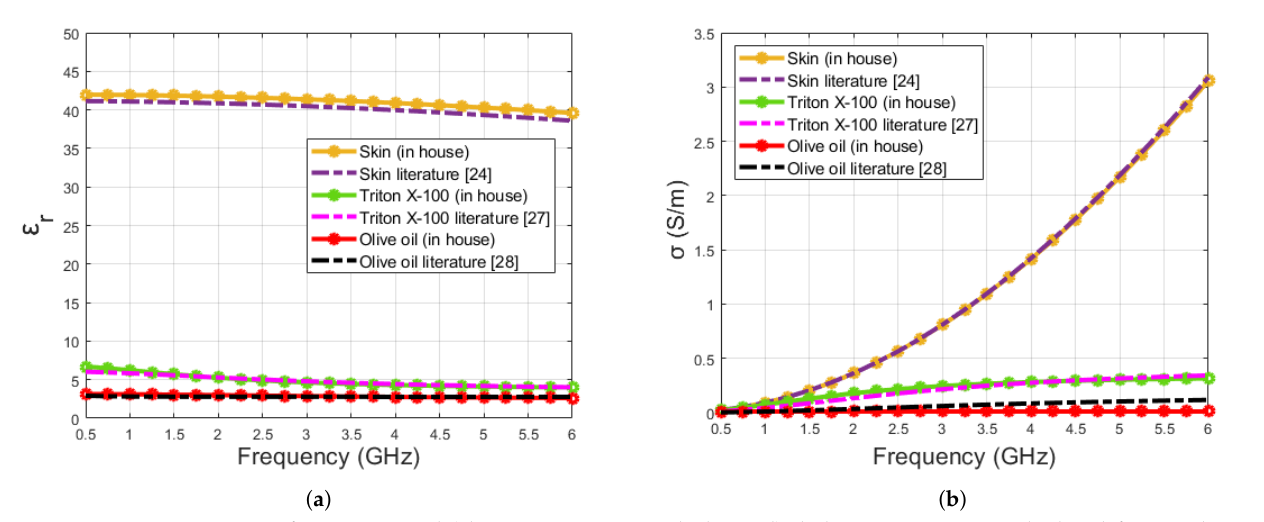
Figure 7. Comparison of pure material (skin, triton X-100 and olive oil) dielectric properties calculated from Debye parameters obtained from the literature and retrieved from the in-house algorithm: ( a ) relative permittivity, ( b ) conductivity. Table 4. Maximum dielectric property discrepancy between retrieved and Debye model for pure materials (skin, triton X-100 and olive oil) used for double-layered configurations in